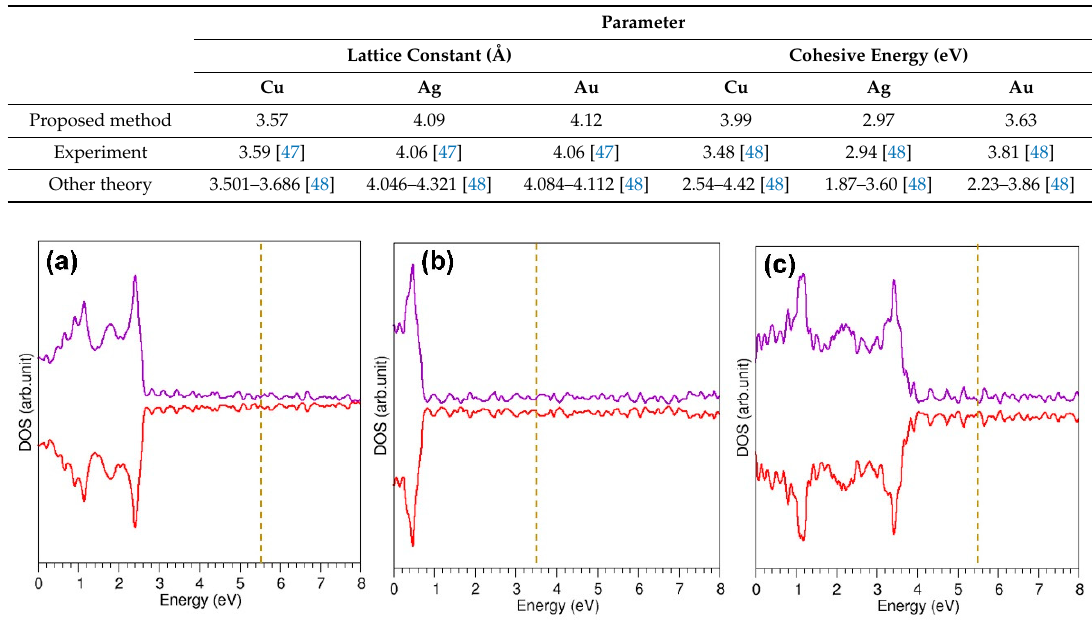
Figure 3. DOS plots for the bulk structures of Cu ( a ), Ag ( b ) and Au ( c ). Dotted lines correspond to the Fermi